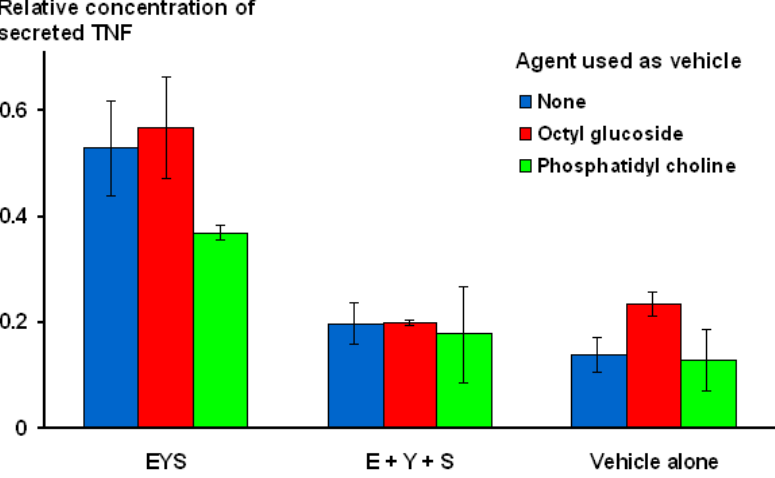
Figure 7. Demonstration that amino acids need to be presented on the same micelle in order to exhibit stimulatory activity.